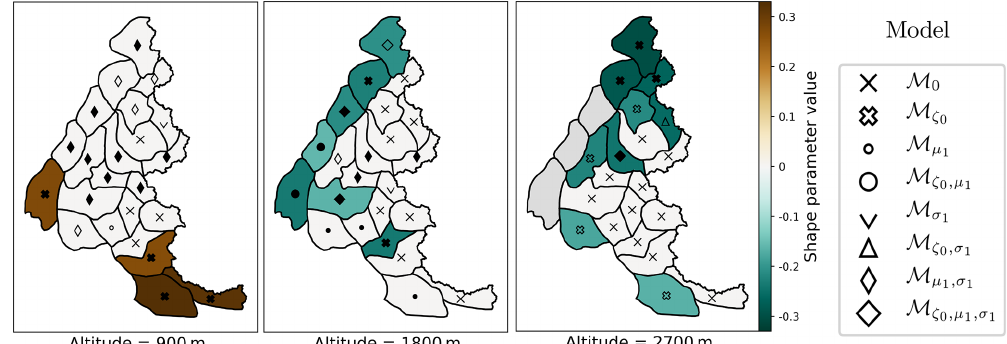
Figure 4. Shape parameter values for the selected models at low (900m), mid (1800m) or high (2700m) altitude. Markers show selected model M N , while filled markers symbolize models that are significantly better than the Gumbel model M 0 (Sect. 4.2). Grey areas denote either time series that were excluded (Sect. 4.4) or missing data, e.g. when the altitude considered is above the top altitude of the